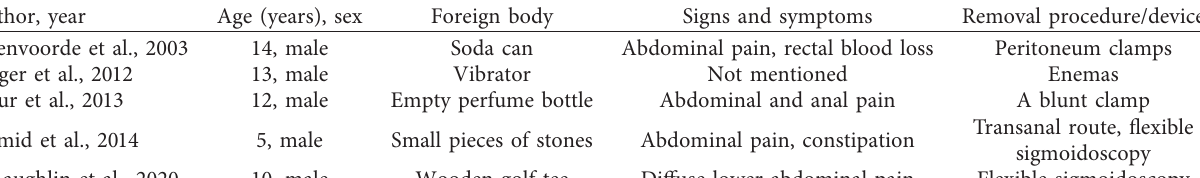
Table 1: Review of literature regarding rectal foreign bodies in pediatrics.